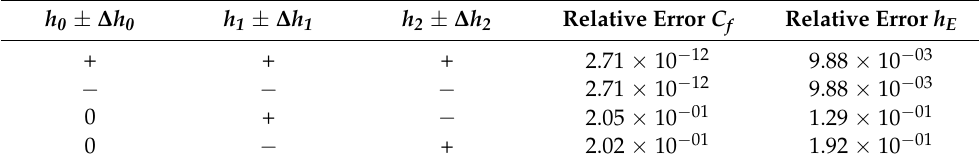
Table 3. Measurement error distribution and calculation